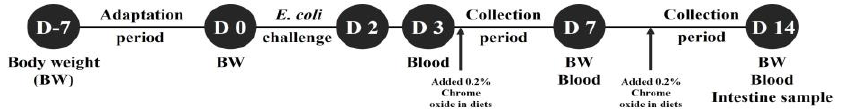
Figure 1. Schematic diagram of the experimental design. Table 1. Compositions of basal diets (as-fed basis).